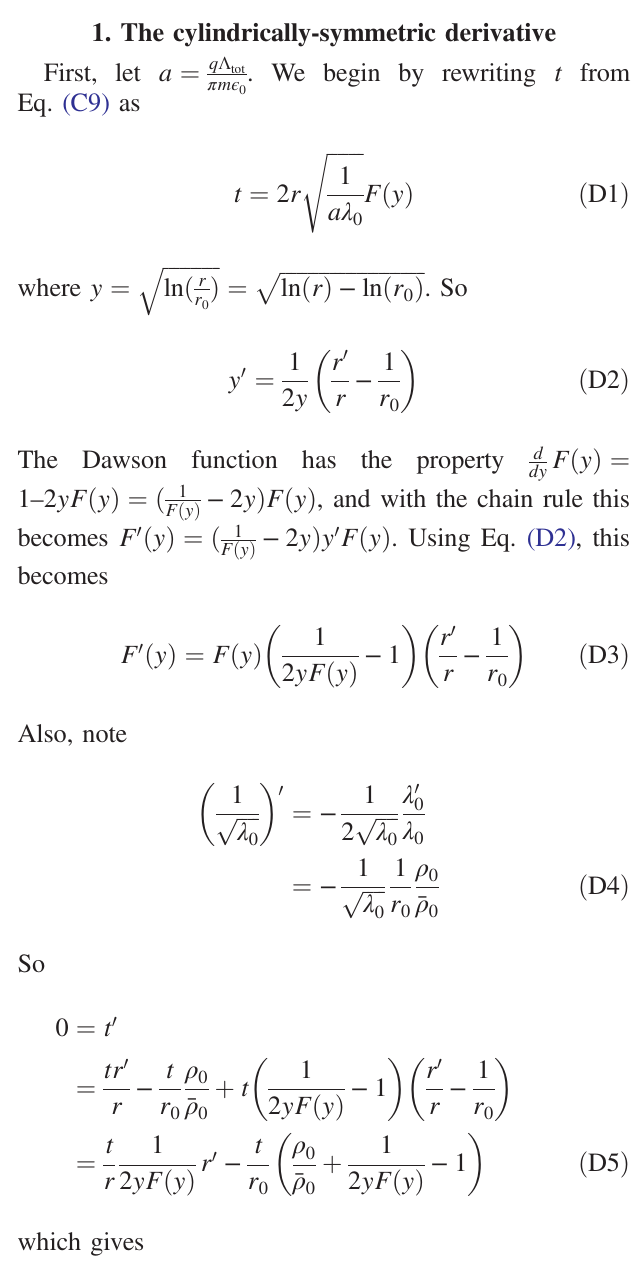
ffiffiffiffiffiffiffiffiffiffiffiffiffiffiffi